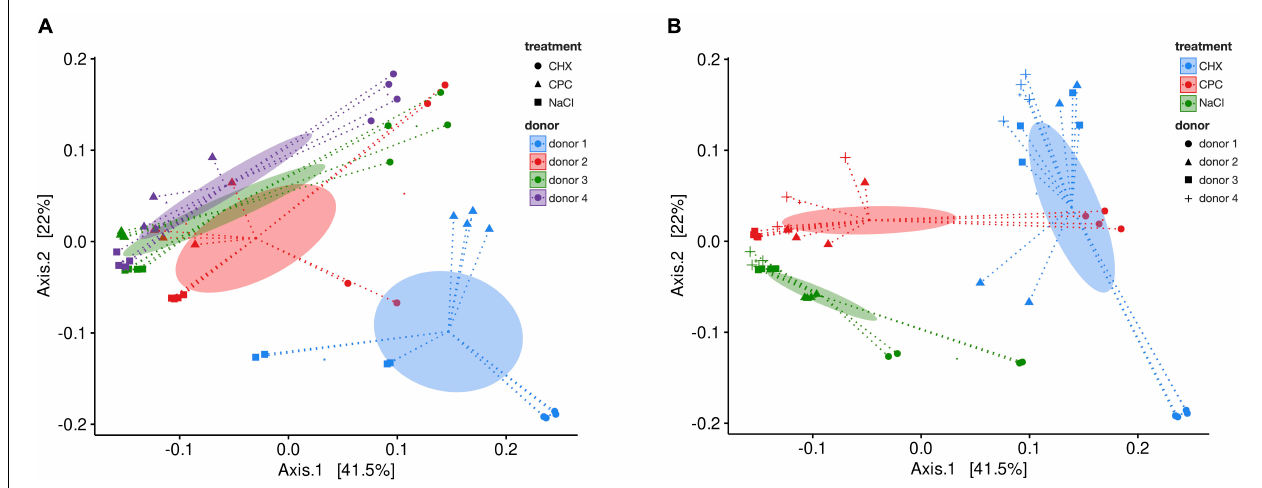
FIGURE 3 | Beta-diversity analysis by principal coordinate analysis (PCoA) of weighted UniFrac distances for NaCl-, CHX-, and CPC-treated biofilms from all four donors. Ellipses indicate the 95% confidence interval of group centroids summarized for donors (A) or treatments (B) . Depicted are coordinates 1 and 2, which explained 63.5% of the total variance. (Adonis NaCl vs. CHX: R 2 = 0.42, p.adj = 0.003, NaCl vs. CPC: R 2 = 0.23, p.adj = 0.003, CHX vs. CPC: R 2 = 0.36, p.adj =